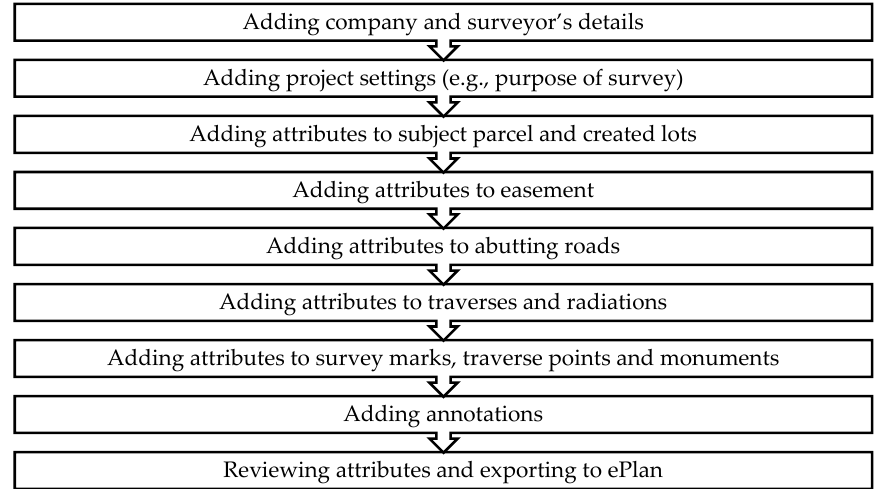
Figure 9. The ePlan creation workflow in Stringer ePlan.